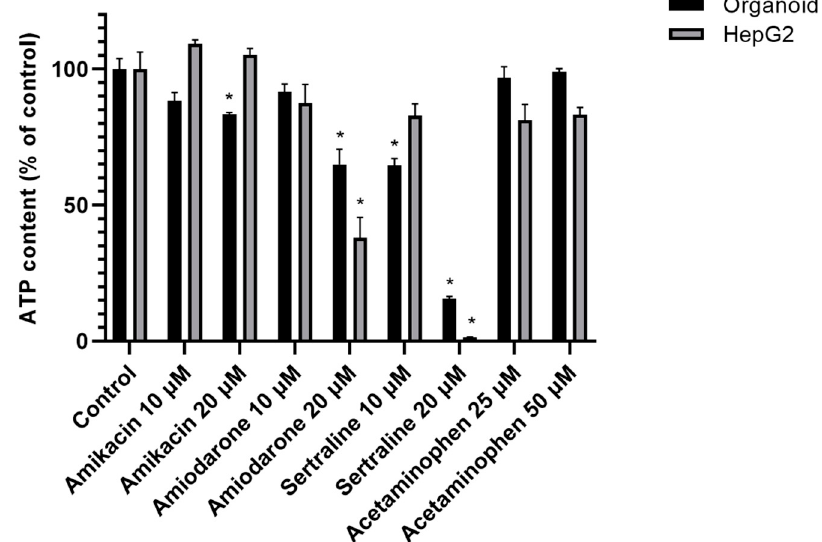
Figure 5. Cell viability changes in organoids and HepG2 cells. Human liver organoids and HepG2 cells were incubated with the indicated drugs (amikacin, amiodarone, sertraline, and acetaminophen) for 48 h. A non-treatment group was used as a control (Con). Cell viability was assessed via the detection of ATP luminescence. Data are shown as a mean ± standard error; * p < 0.05. The experiments were performed in triplicate, each being repeated at least three times.